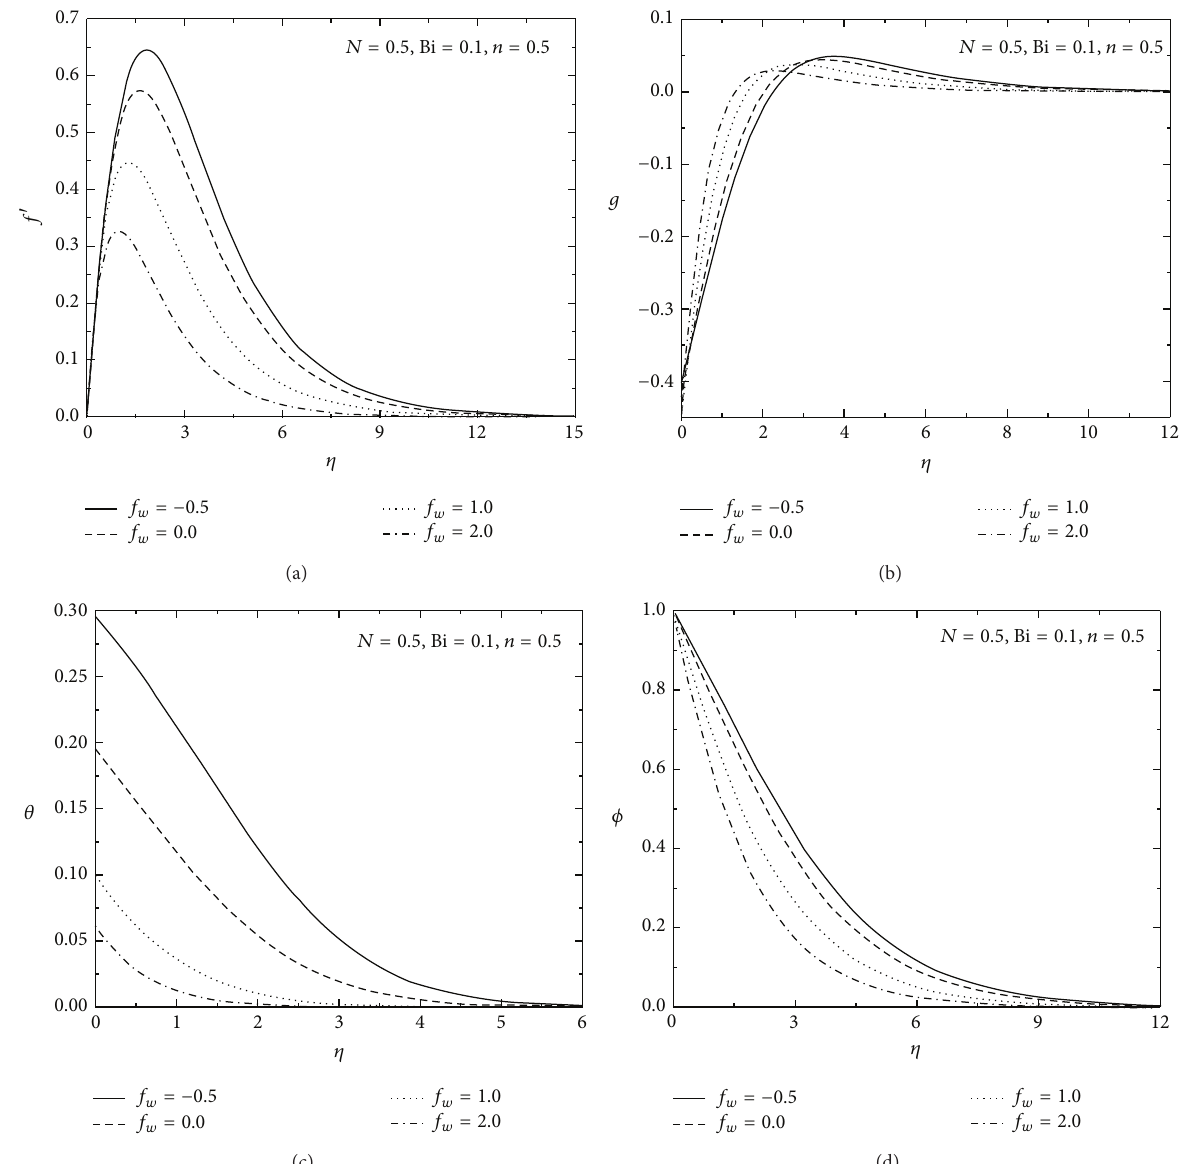
Figure 4: Effect of 𝑓 𝑤 on (a) velocity, (b) microrotation, (c) temperature, and (d) concentration profiles.